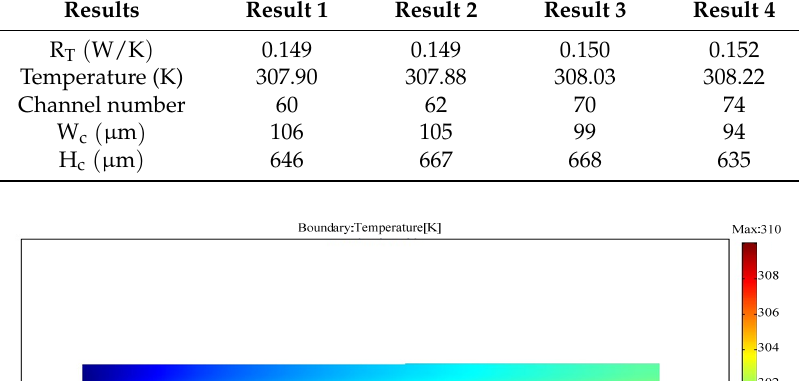
Table 4. Optimal results of the single objective function in Case 2.